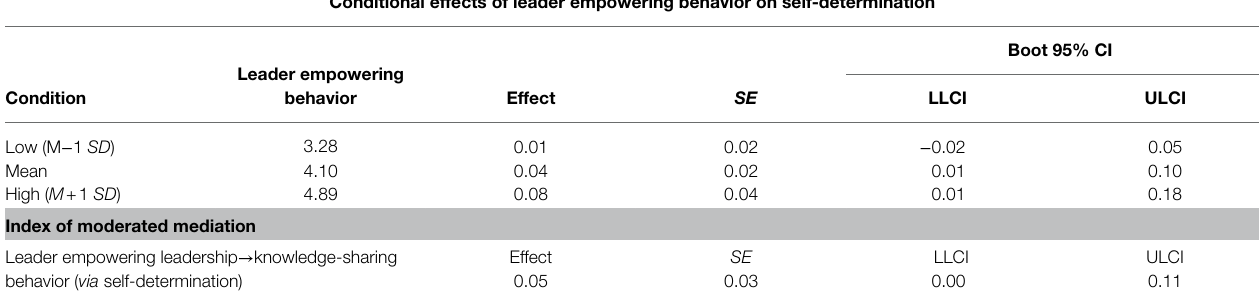
TABLE 4 | Moderated mediation results of bootstrapping method with 5,000 resamples.